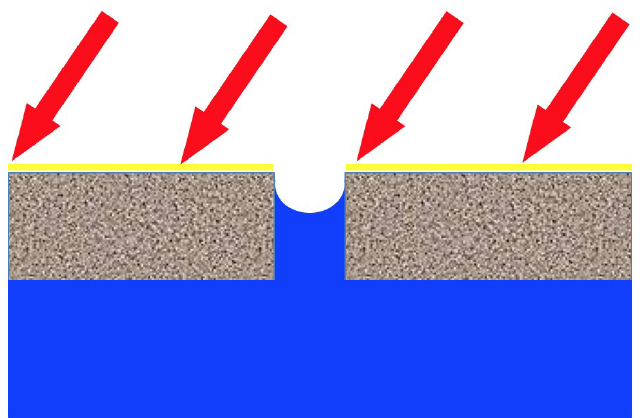
Figure 11. Microscale pores for vapor generation: the yellow layer is the absorber that absorbs solar energy; under the absorber is the insulator; liquid is shown as the blue region of the figure; vapor is generated from